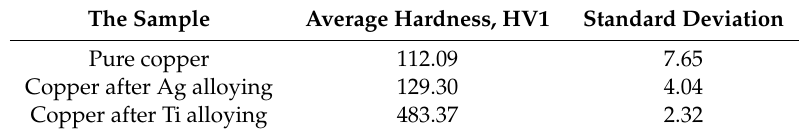
Table 4. Averaged results obtained from the hardness measurements using the Vickers method.